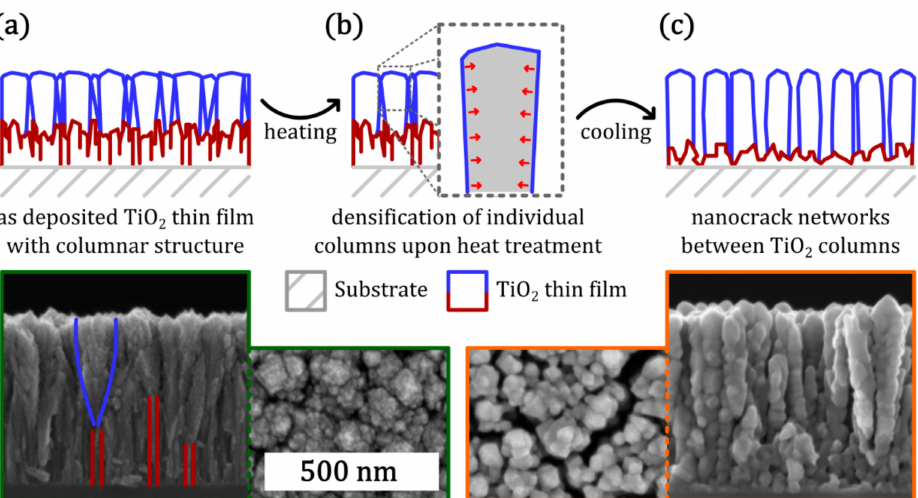
Figure 4. Overview on the process of nanocrack network formation in TiO 2 thin films deposited by sputter deposition: ( a ) schematic cross-section of the as-deposited TiO 2 thin film; ( b ) morphologic changes upon heat treatment; ( c ) schematic cross-section of the TiO 2 thin film with characteristic nanocrack networks formed after heat treatment. (SEM micrographs (having same scale bar of 500 nm) given at the bottom show in cross-sectional as well as top view configurations for the as-grown (green border) and the heat treated (orange border) TiO 2 thin films). Adapted with permission from [17]. Copyright (2018)